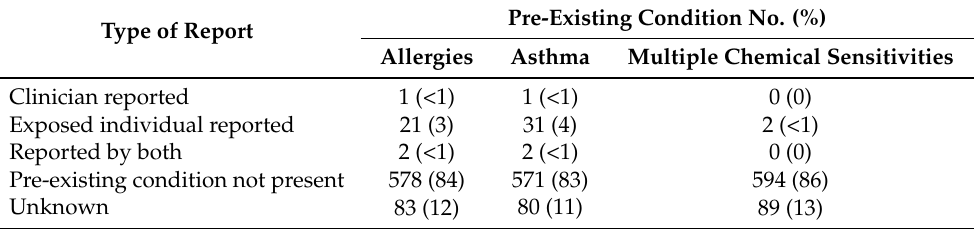
Table 3. Distribution of events in childhood reported by pre-existing condition that could impact response to exposure.